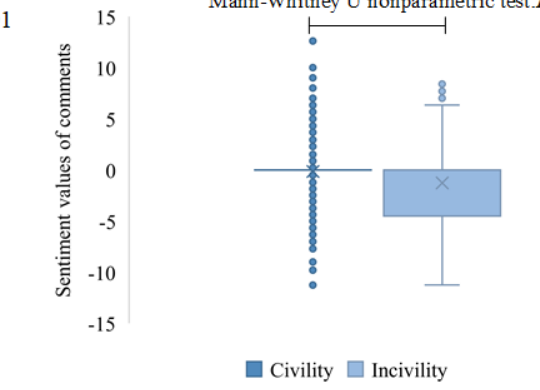
Figure 12. The distribution of sentiment values for retweets (left) and comments (right) containing civil and uncivil content. The × symbols and circles represent means and outliers of the sentiment values,